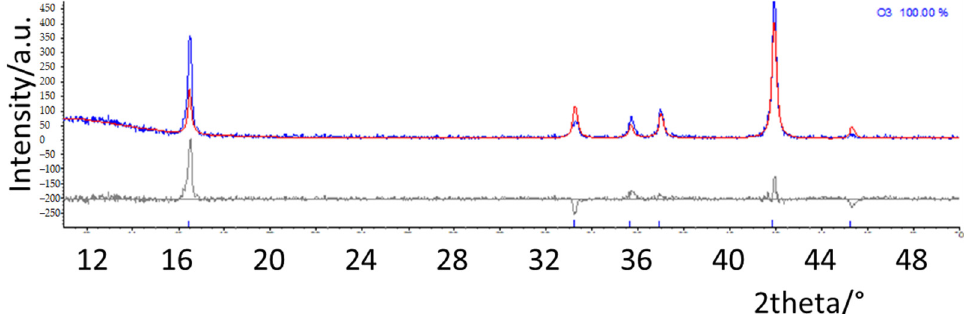
Figure 2. Rietveld refinement of NMNO-Ti pattern. The experimental curve (blue) is compared with the calculated one (red), and in the bottom, the difference curve (grey) and the bars of the expected peak positions of the phases are also shown.